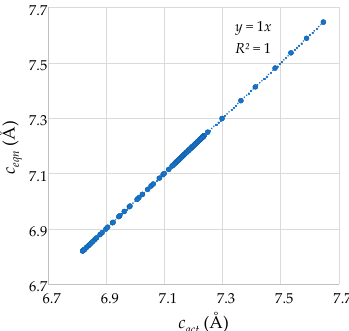
Figure 11. The variation with pressure p of the intra and inter-square angles with the intra-square angles remaining practically constant at 90° throughout the whole range of applied pressures, whilst the inter-square angle tending to 90° at high negative pressures (‘fully open’ conformation) and to 0° (‘fully closed’ conformation) at extreme positive pressures. Note that at p = 10 GPa, the inter- square angle had already decreased to just c. 16° and at p > c. 58 GPa, the inter-square angle is less than 0°. This may be permitted since the tetrahedra which project as squares occupy different size by up to 100%) thus explaining why this material is so extensively compressible in the ‘depth’ down the c -direction, i.e., do not physically overlap. a and b directions.